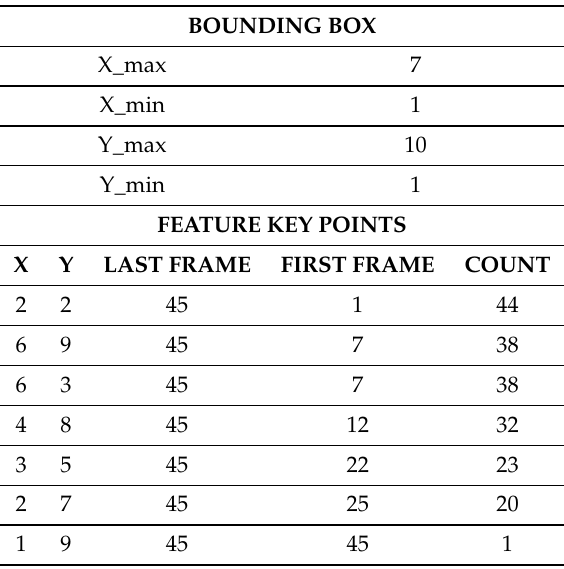
Table 1. The bounding box’s coordinates (left table) and the key points detected from the first frame to the 45th frame (right table). For each key point which is inside the bounding box’s coordinates, the count value (which is the difference between the first frame and the last frame it was detected in) determine the steady